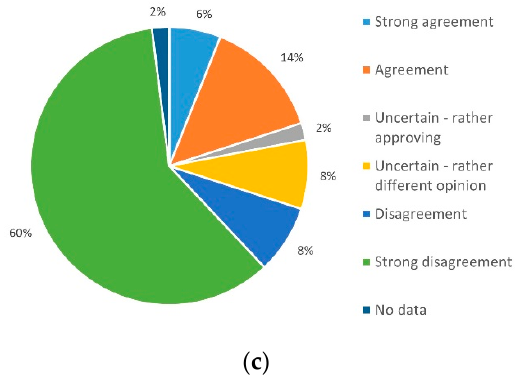
Figure 7. Expectations that ( a ) telemedicine affects individual health, ( b ) regular visits can be replaced, and ( c ) personal contacts will become obsolete